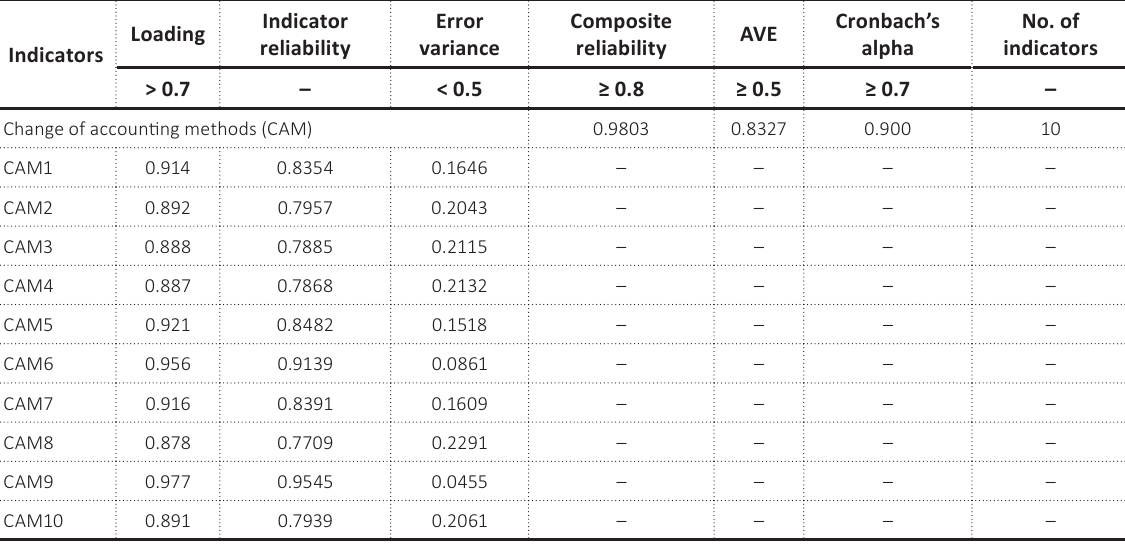
Table A2. Confirmatory factor analysis (change of accounting methods)